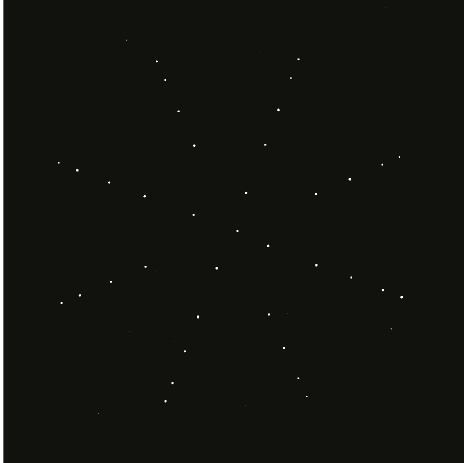
Figure 5: Image of the 37 control points.